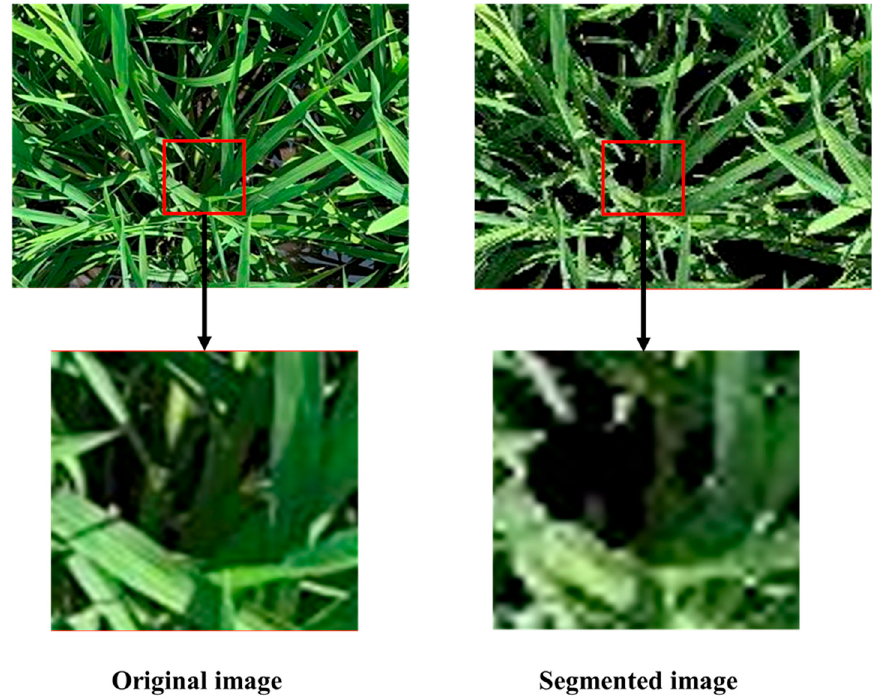
Figure 8. Bottom leaves of the rice canopy below the threshold.